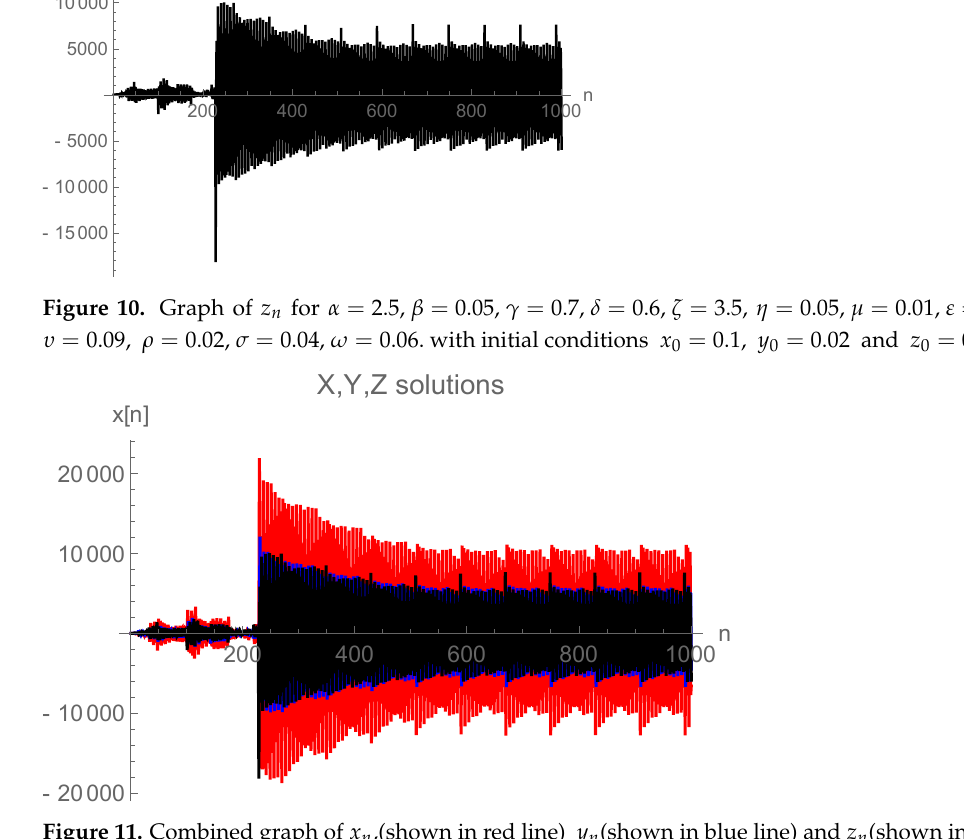
Figure 11. Combined graph of x n ,(shown in red line) y n (shown in blue line) and z n (shown in black line) for α = 2.5, β = 0.05, γ = 0.7, δ = 0.6, ζ = 3.5, η = 0.05, µ = 0.01, ε = 4.1, υ = 0.09, ρ = 0.02, σ = 0.04, ω = 0.06. with initial conditions x 0 = 0.1, y 0 = 0.02 and z 0 = 0.04.